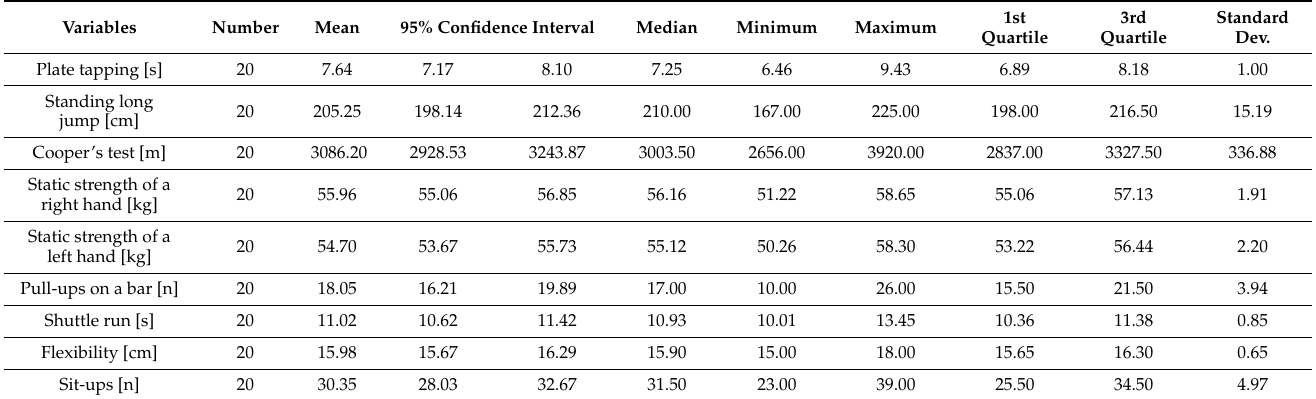
Table 2. The rezults of fitness test.